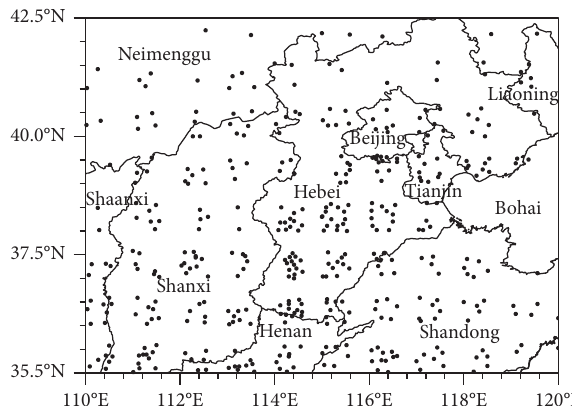
Figure 1: Distribution of 421 observation stations in North